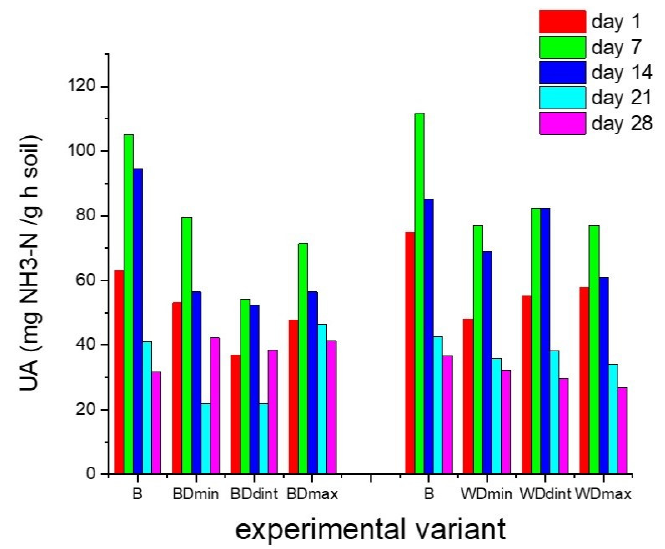
Figure 4. Soil urease activity (UA) for each experimental variant, determined every 7 days for 28 days: B—seeds untreated with triticonazole, BDmin, and WDmin—barley and wheat seeds treated with the minimum dose, DBint, and WDint—barley and wheat seeds treated with the intermediate dose, BDmax, and WDmax—barley and wheat seeds treated with the maximum dose of triticonazole.